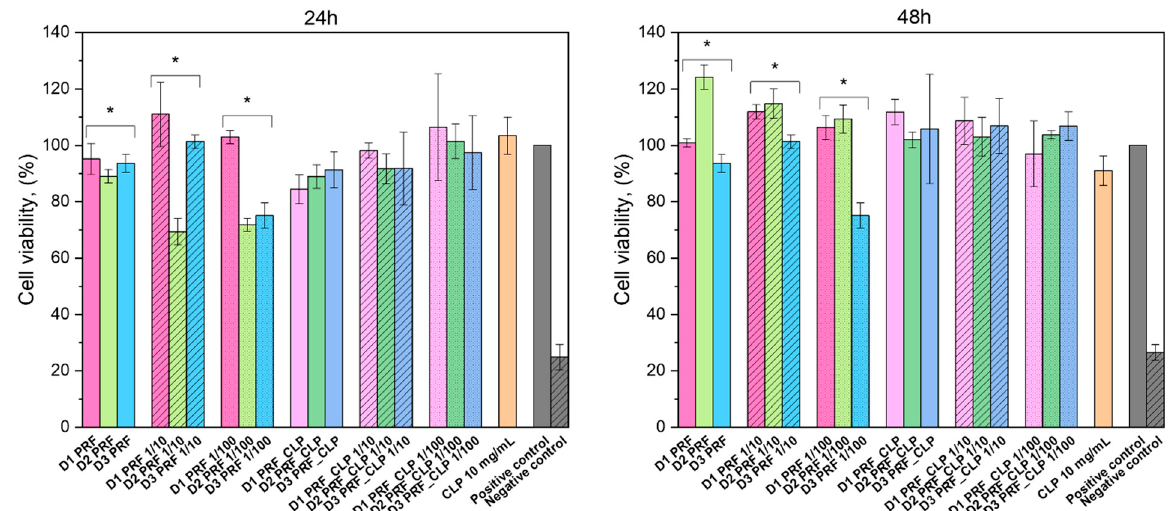
Figure 8. Cytotoxicity of PRF and PRF-CLP extracts and dilutions (significant statistical difference (* p ˂ 0.05)).